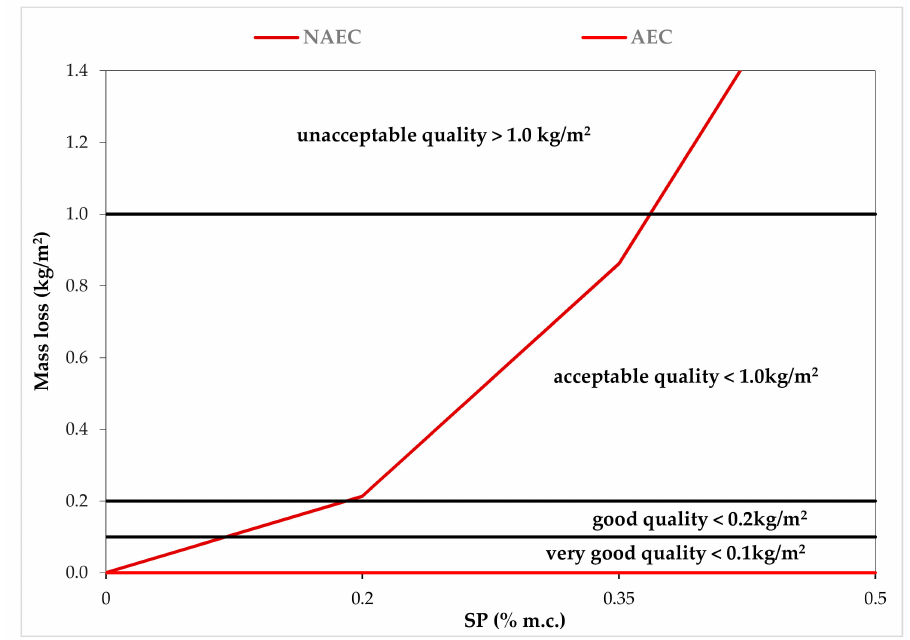
Figure 4. Dependence of mass loss after 56 cycles of scaling on superplasticizer (SP) content in the non-air-entrained concrete (NAEC) and air-entrained concrete (AEC)